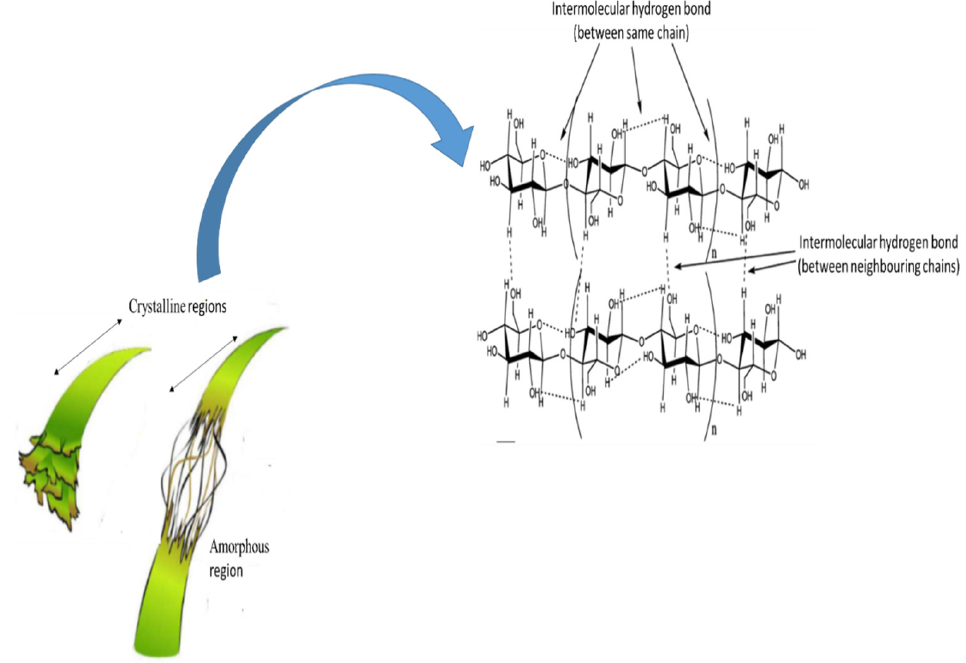
Figure 5. Intramolecular and intermolecular hydrogen bonds in crystalline cellulose (adapted and modified from Hasan et al. [54]).